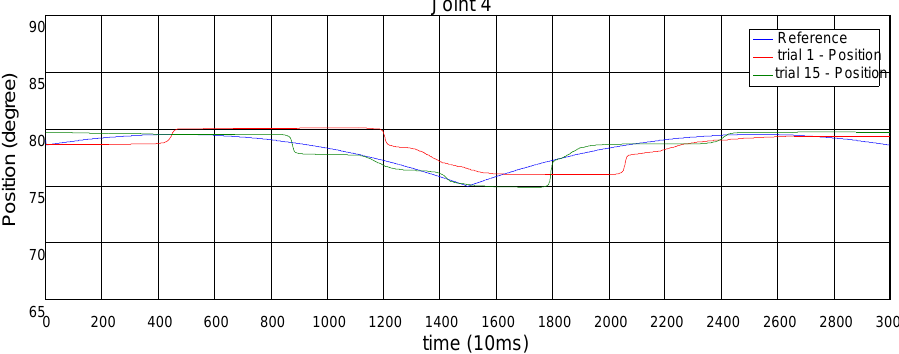
Figure 25. Trajectory 1—3rd-axis (load-on) ILC trial 1 and trial 20 tracking and error diagrams.